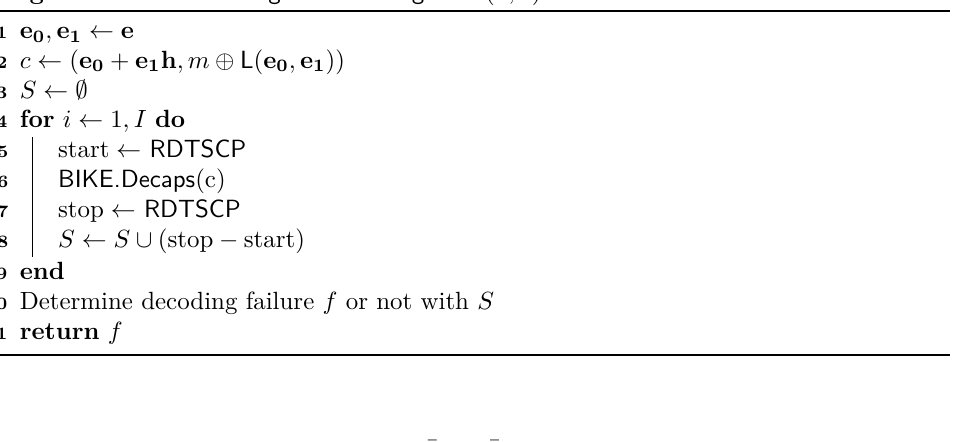
Algorithm 15: DecodingFailureDistinguisher ( e , I